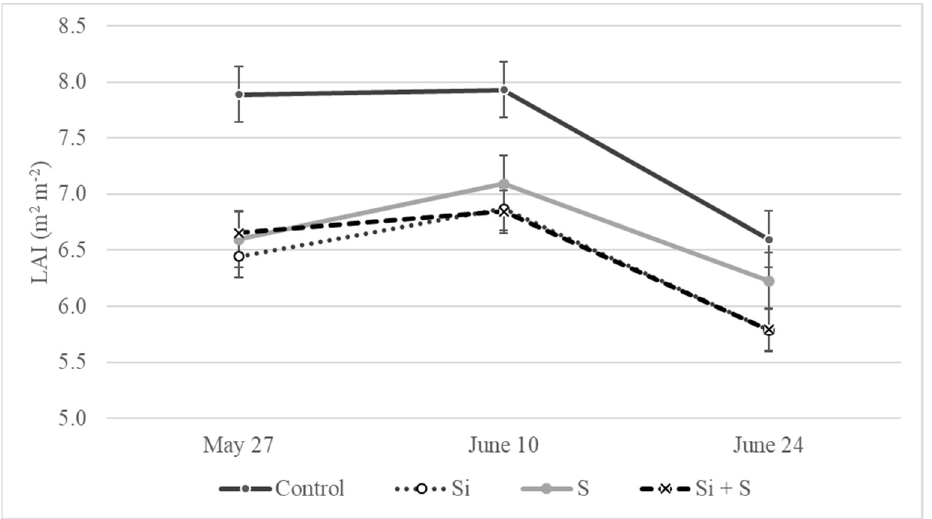
Figure 11. LAI values for winter oat as an effect of the treatments (Debrecen, 2021); Means of the varieties, ± standard error. The differences among the treatments were significant at p = 0.05.